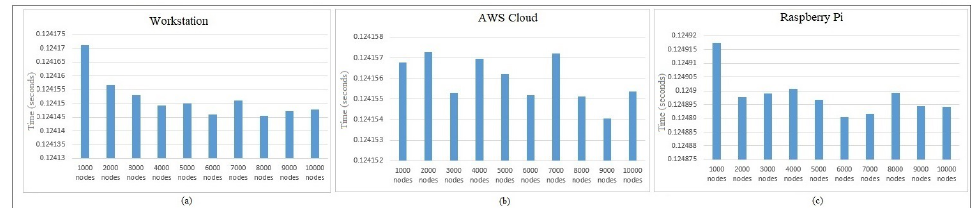
Figure 6. Independent protocol performance time on the ( a ) workstation, ( b ) AWS Cloud, and